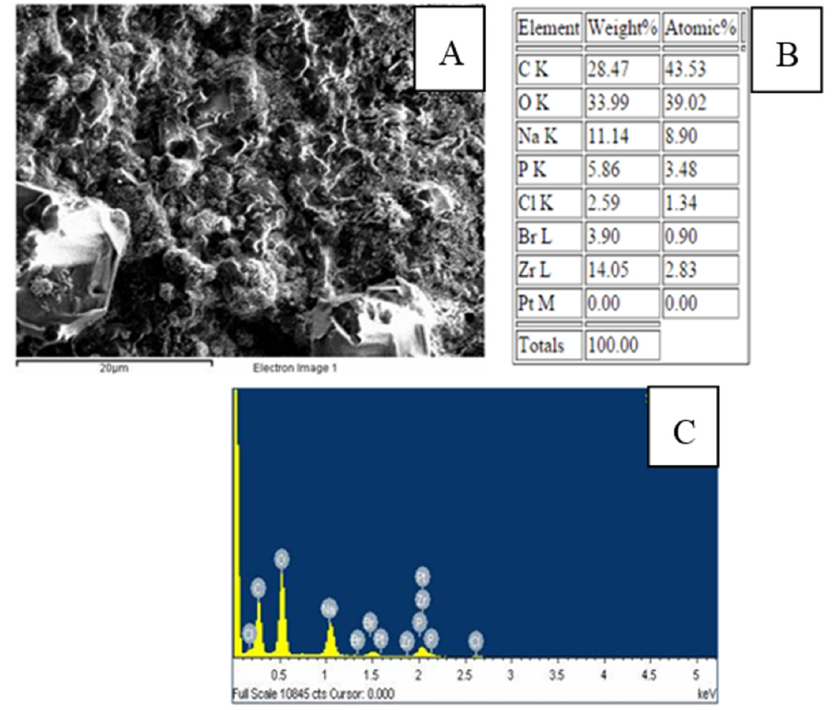
Figure 3. Scanning electron microscopy (SEM) photographs ( A ); table of EDX analysis; ( B ) and spectrum of SPCE/PEG-ZrO 2 ( C ).